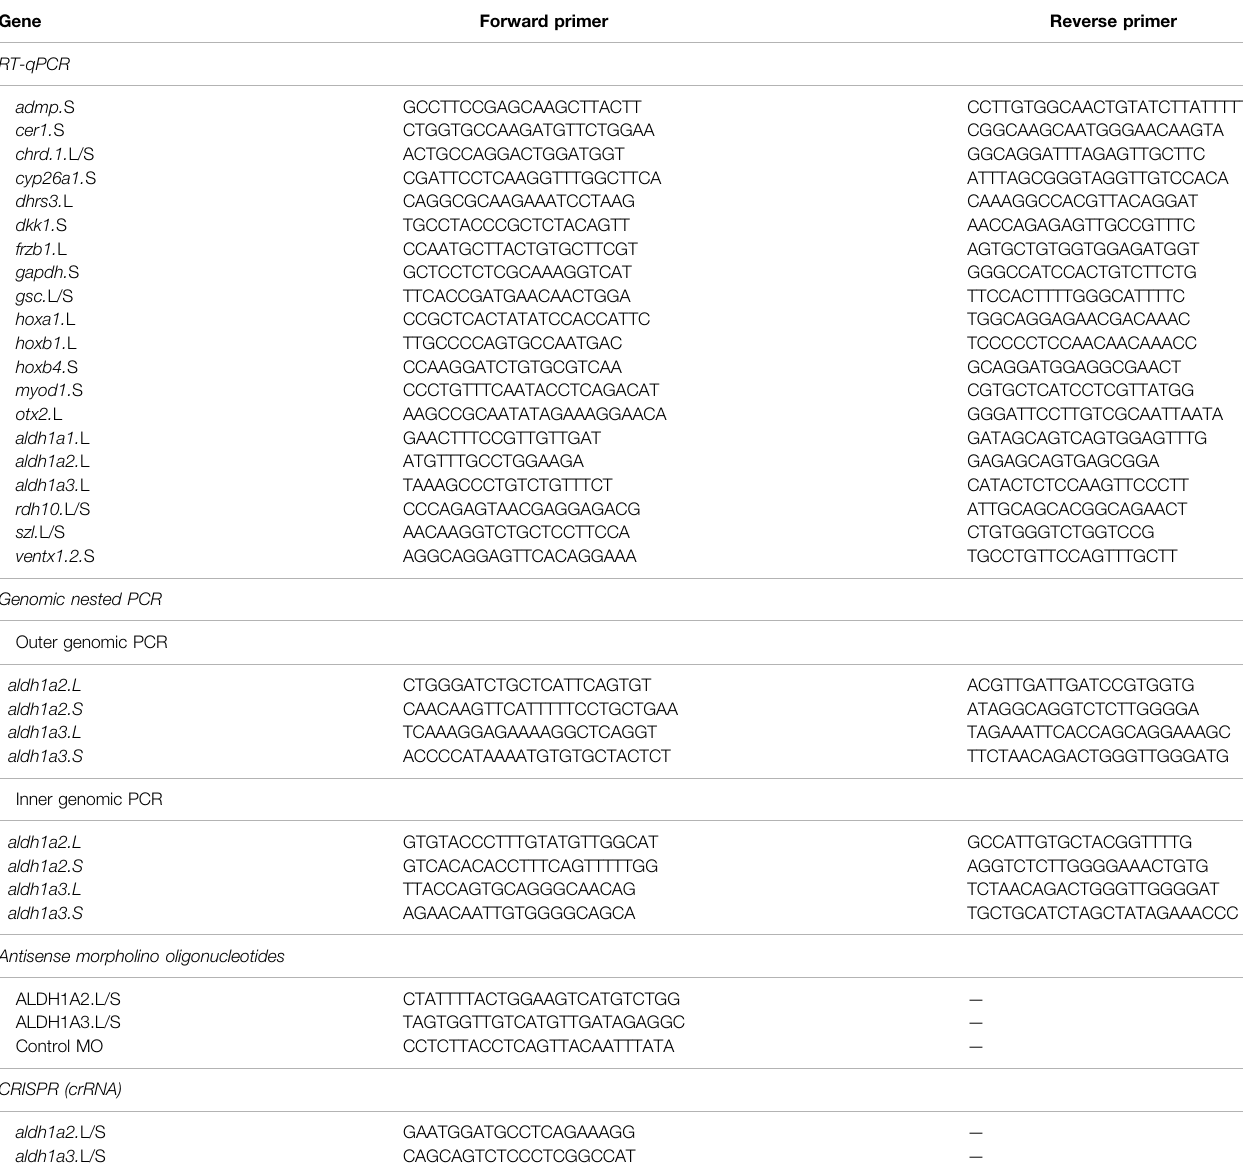
TABLE 1 | Primers for PCR expression analysis, genomic ampli fi cation and expression knockdown. Gene Forward primer Reverse primer RT-qPCR admp.